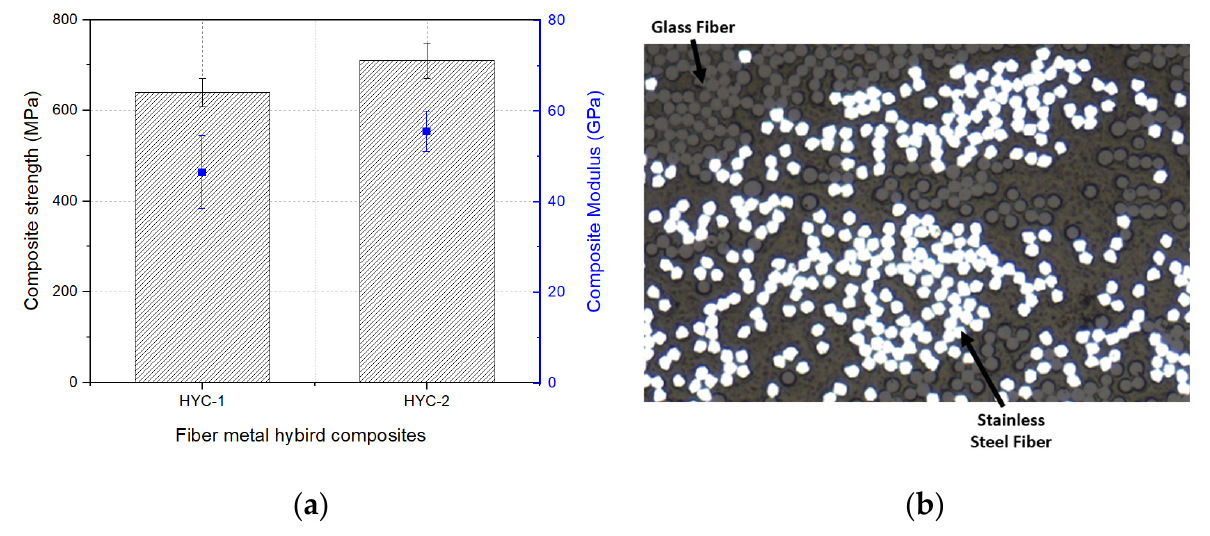
Figure 10. GF/stainless-steel/PA6 hybrid composites: ( a ) tensile properties and ( b ) cross-sectional view of HYC-2 hybrid composite.